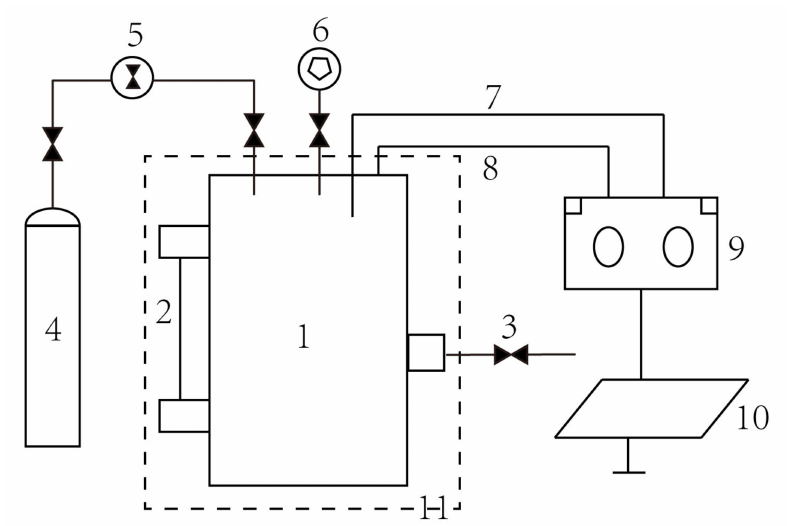
Figure 1. The experimental system. 1. Bioreactor, 2. Sight glass, 3. Sample collection, 4. Methane cylinder, 5. Regulator, 6. Vacuum Pump, 7. Temperature sensor, 8. Pressure sensor, 9. Data acquisition, 10. Computer, 11. Air